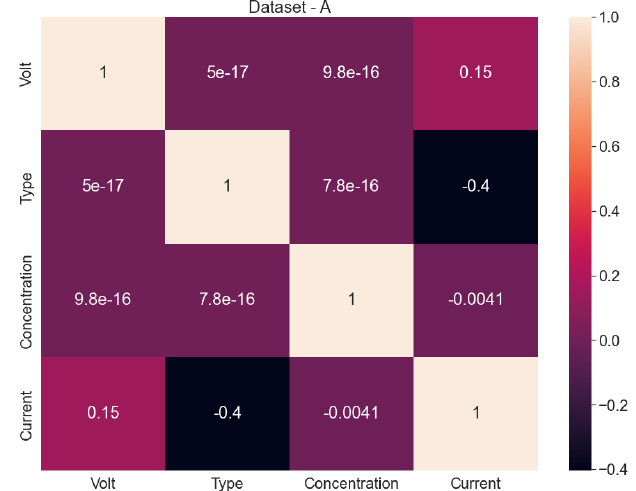
Figure 5. Correlation matrix of Dataset A.